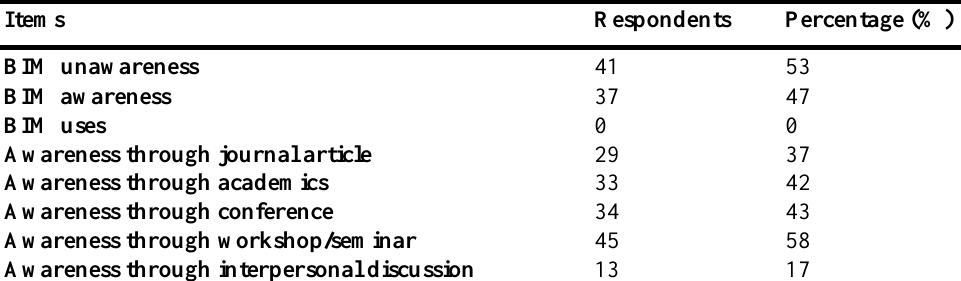
Table 5. The Level of Awareness of BIM as a Strategy for PB Management (developed by the